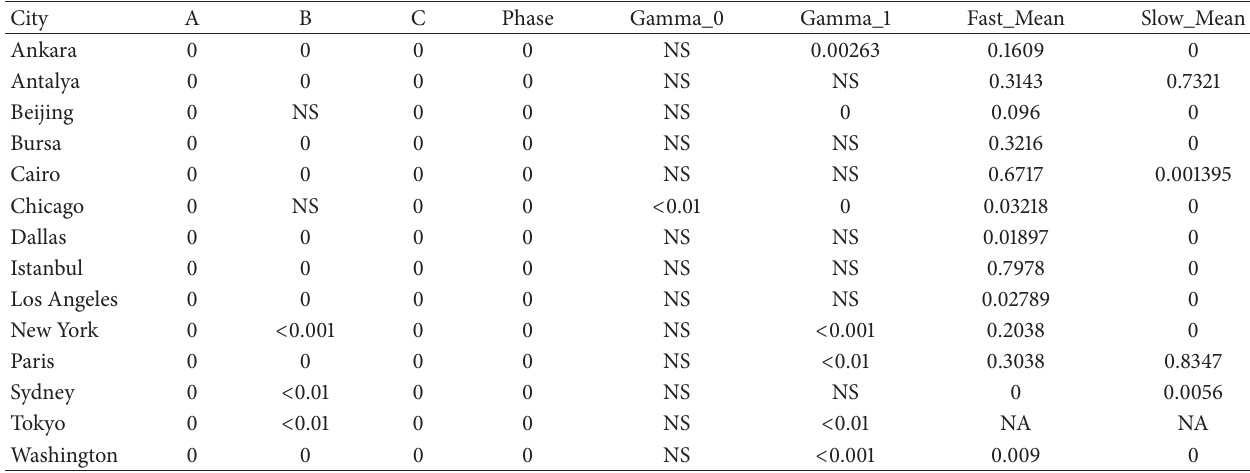
Table 6: 𝑃 values of parameters for CDD